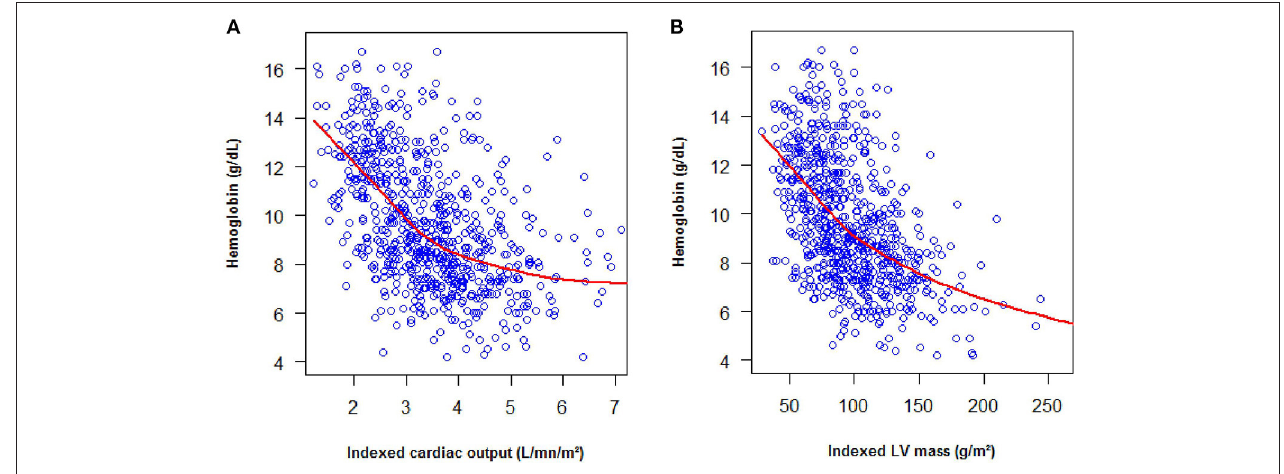
FIGURE 1 | Evolution of cardiac output (A) and LV mass (B) depending on the level of hemoglobin.